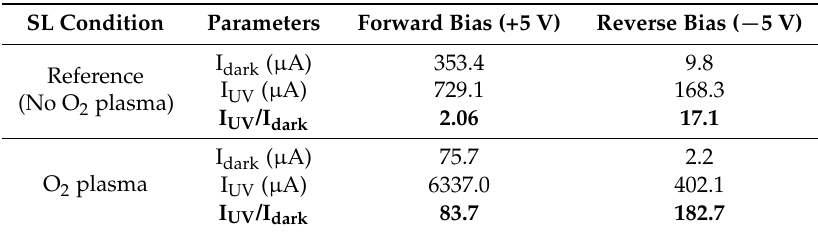
Table 3. Summary of the measured UV-to-dark current ratios at bias conditions of +5 and − 5 V from the p-Si/n-ZnO-NR heterojunction